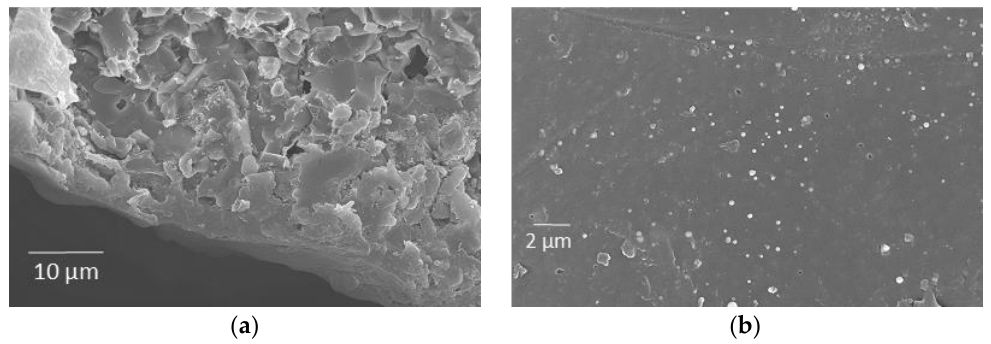
Figure 5. ( a -left): cross-sectional and ( b -right) top-view images of Sample C1-TS after 17 coating cycles and a pyrolysis temperature of 1000 °C.